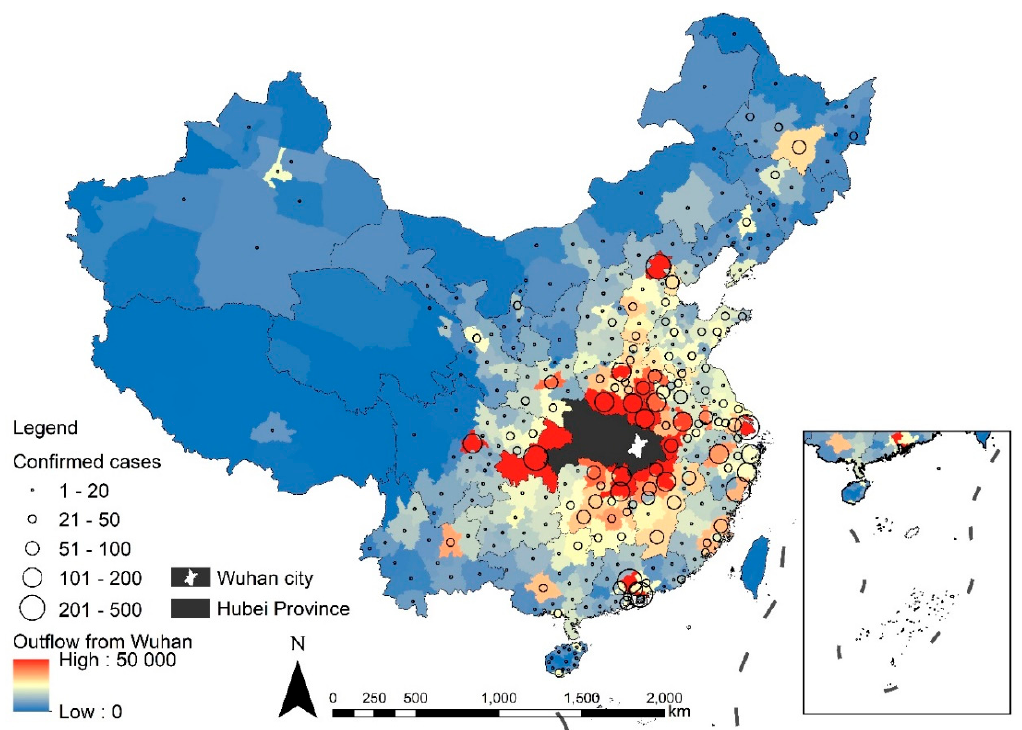
Figure 2. Spatial distribution of population outflow from Wuhan and cumulative confirmed COVID-19 cases.